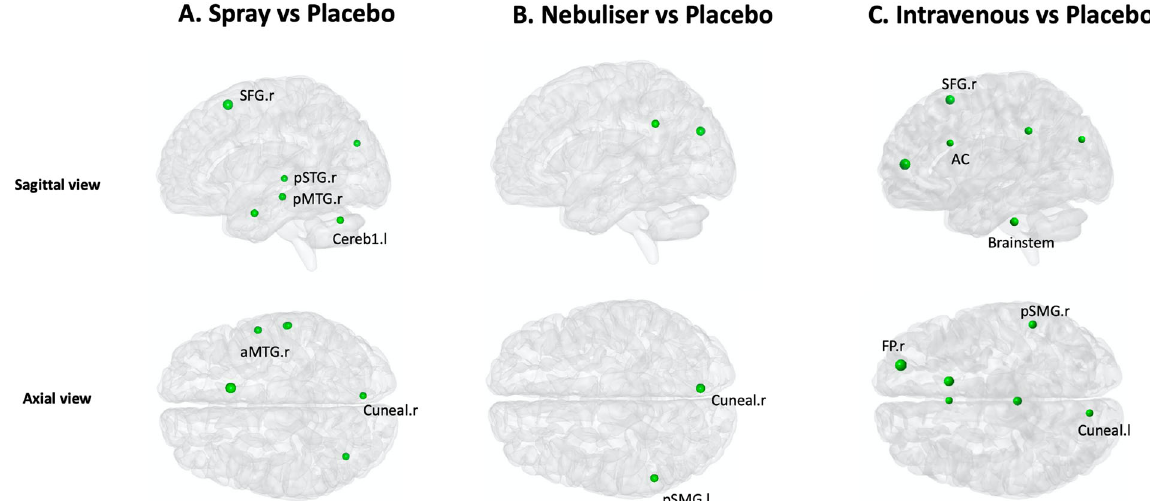
Fig. 3 Effects of exogenous oxytocin on nodal local ef fi ciency. For each node, we compared local ef fi ciency between the four treatment conditions using repeated measures one-way analysis of variance. Since we performed tests for multiple nodes, we controlled false positives using FDR correction for the number of nodes examined. When a signi fi cant effect was found, we explored this effect further using paired t -tests for each pair of treatment groups, correcting for multiple testing using FDR. In this fi gure, we provide an overview of the pattern of changes in local ef fi ciency for each method of administration by showing the results of the post-hoc tests focusing on the comparisons between each active treatment arm and placebo (for direct comparisons between active treatment arms, please refer to Table S2). The green and red colours depict increases and decreases in local ef fi ciency, respectively. The size of each nodal sphere is proportional to the T-statistic of each comparison. The name of each node appears once, in the axial or sagittal view, to avoid cluttering the fi gure. R right, l left, a anterior, p posterior, SFG superior frontal gyrus, STG superior temporal gyrus, MTG medial temporal gyrus, SMG supramarginal gyrus, Cereb Cerebellum, Cuneal cuneal cortex, AC anterior cingulate, FP frontal